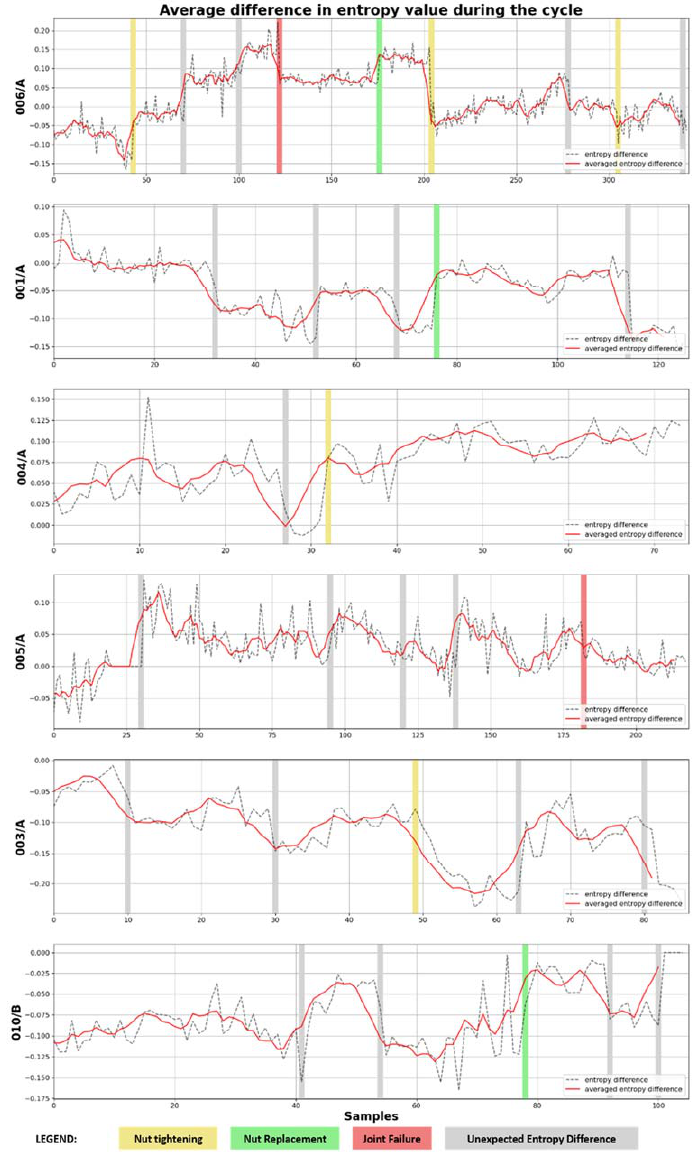
Figure 9. Comparison of the average difference in entropy values during the cycle for various ma ‐ chines.